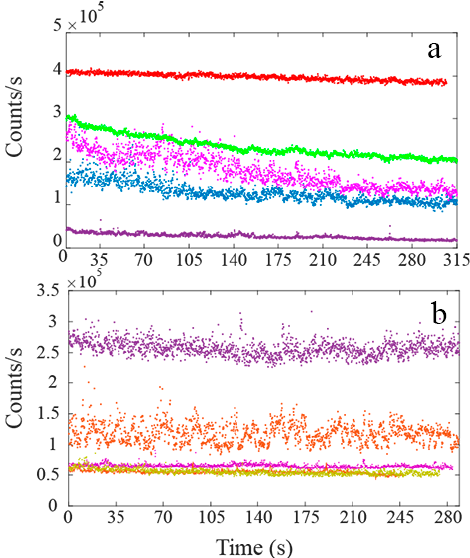
Figure 2. ( a ) Two-dimensional confocal fluorescence maps (100 × 100 μ m 2 ) for ( a ) commercial and ( b ) ball-milled MgO NPs, excited with 200 μ W power. The insets show fine scans of 10 × 10 μ m 2 dimensions. The fluorescence intensity detected by the SPAD is expressed in counts per second (counts/s).